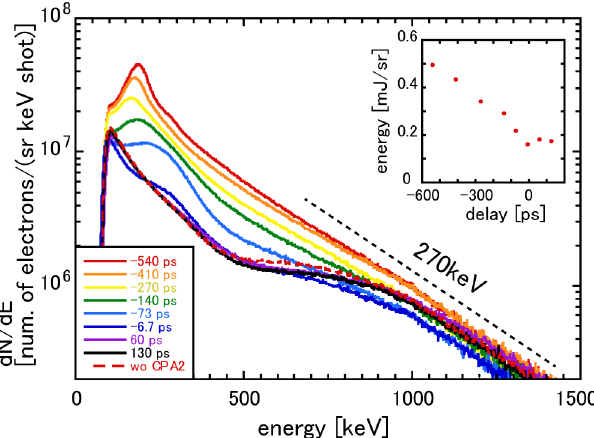
FIG. 2. Dependence of the electron energy spectrum on time delay. Spectra are obtained by averaging 100 shots. The energy spectrum without the CPA2 pulse is almost the same as those for positive time delay. The inset shows the time-delay dependence of the amount of electron energy as measured by the magnetic spectrometer. The deviation of the electron energy is about